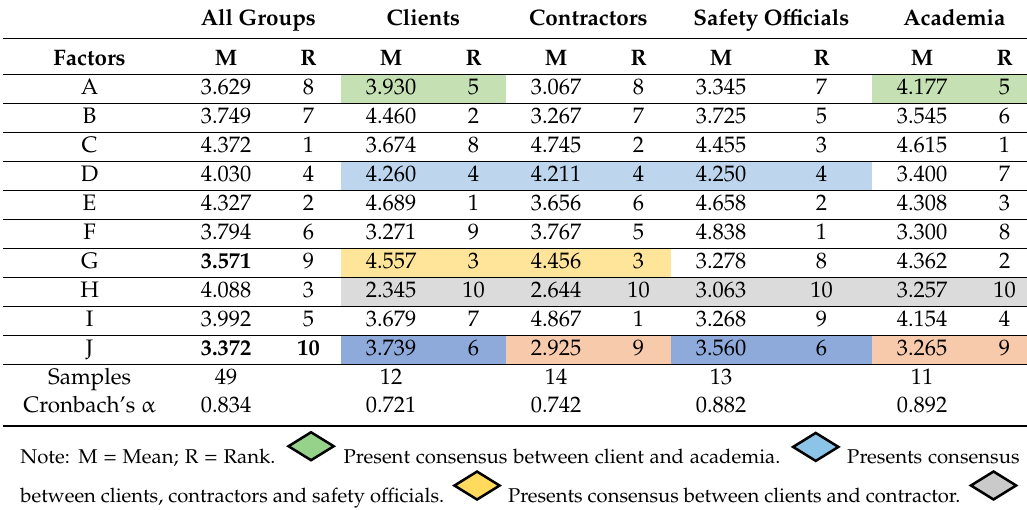
Table 5. Second Round of Delphi Survey.